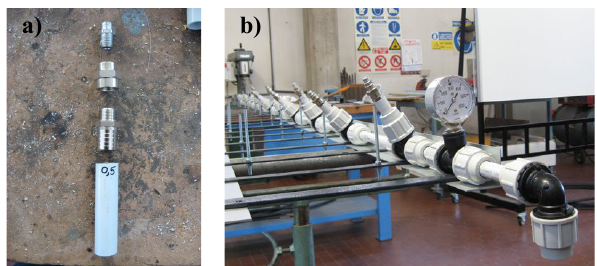
Figure 1. Nozzle line setup. (a) Nozzle assembly. The threaded pressure washing nozzle was connected to a short length of PVC pipe using two connectors. (b) Alternating angles of nozzles and pressure gauge used to regulate